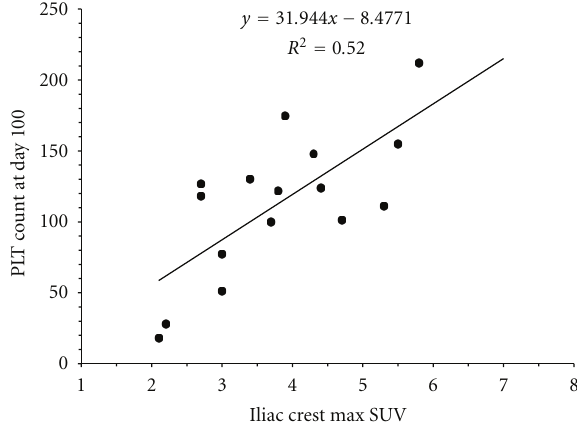
Figure 4: Correlation between follow-up platelets counts (day 100) and metabolic activity in both the iliac crests at day 30 after IB-CBT; maximal SUVs in the injected sites were significantly and directly correlated with the follow-up platelets recovery.